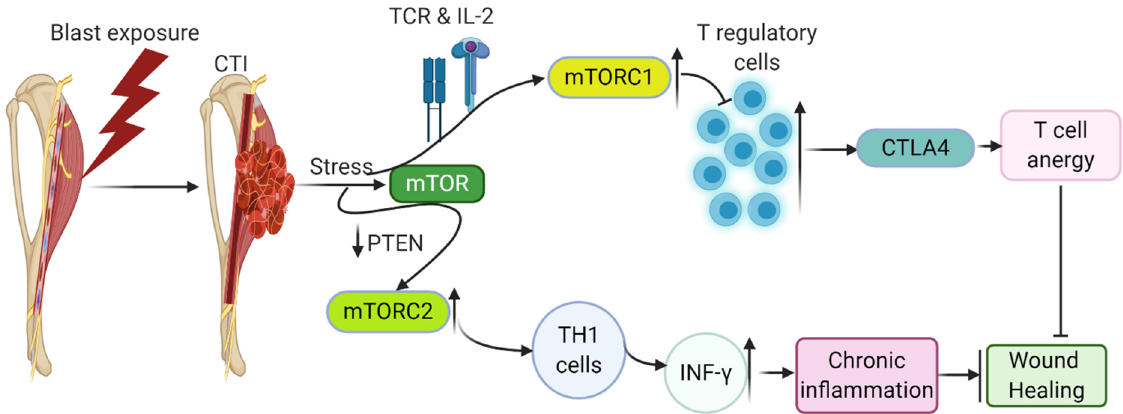
Figure 3. Changes in the mTOR metabolic pathway due to stress created by CTI triggers anergy in T cells, delaying adaptive immune responses by supporting the induction of pro-inflammatory cytokines, leading to chronic inflammatory conditions and delay/inhibit wound healing.